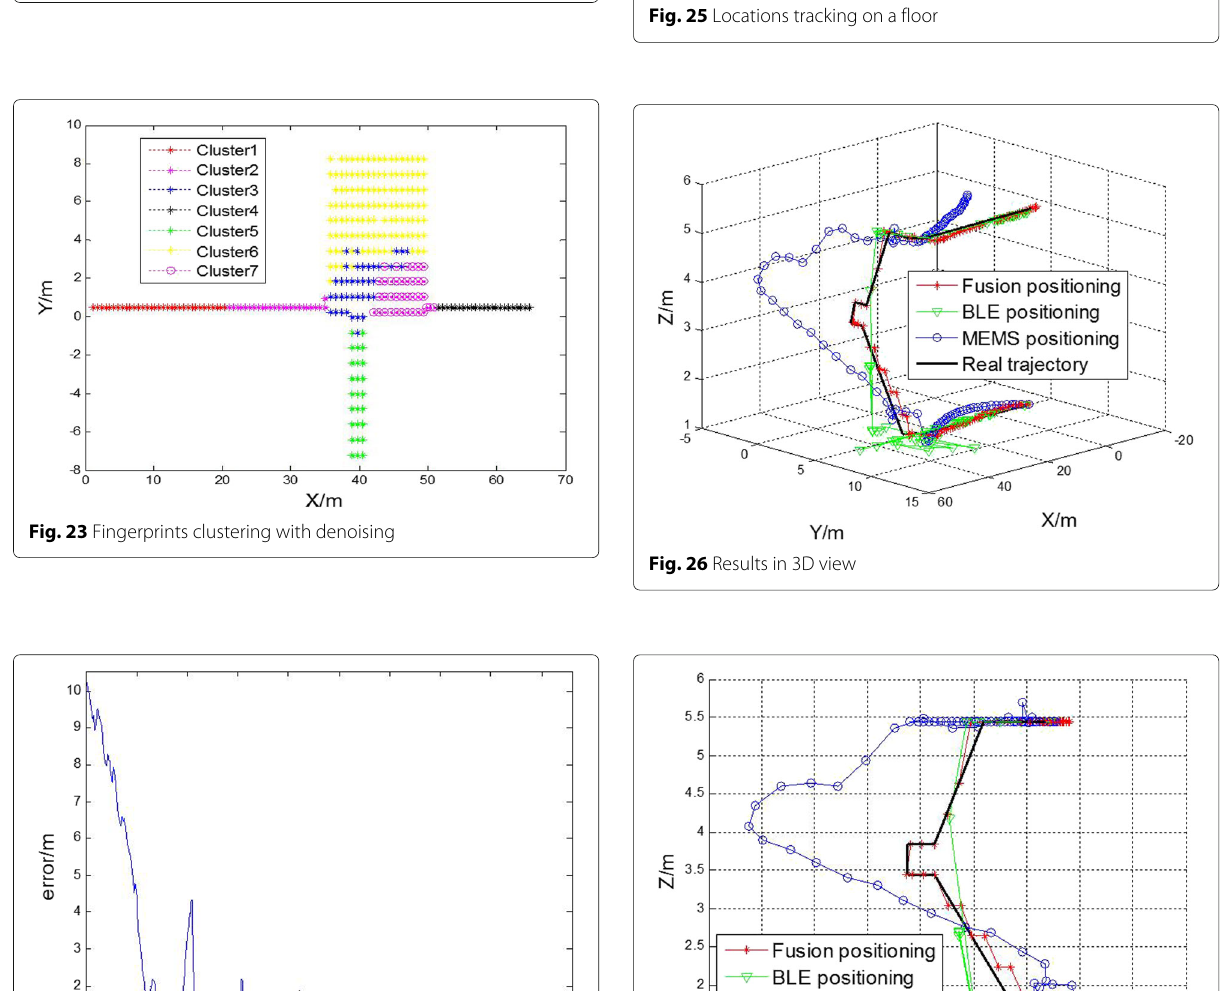
Fig. 22 Fingerprints clustering without denoising